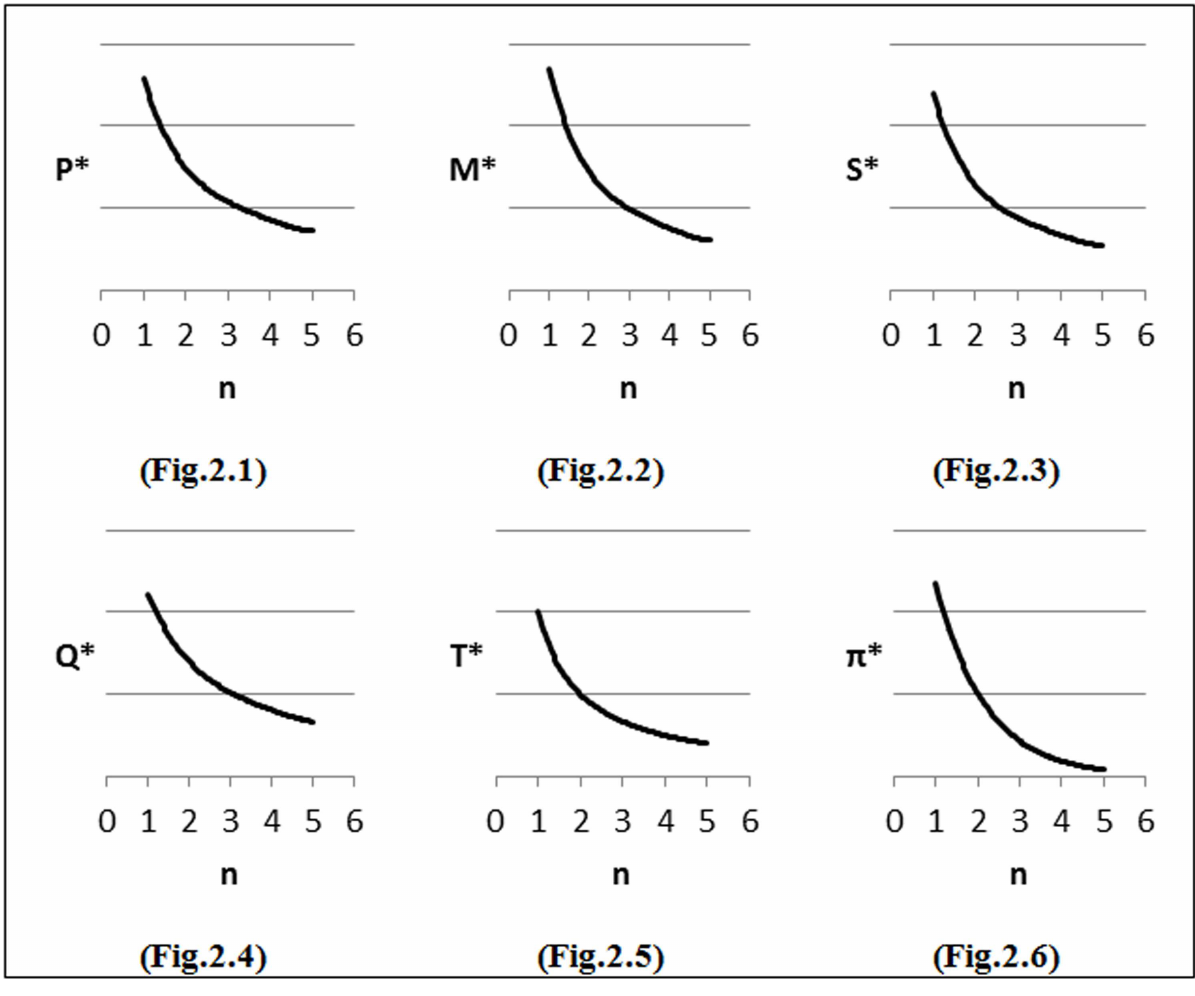
Fig 2. Effects of changes in ( α ) on decision